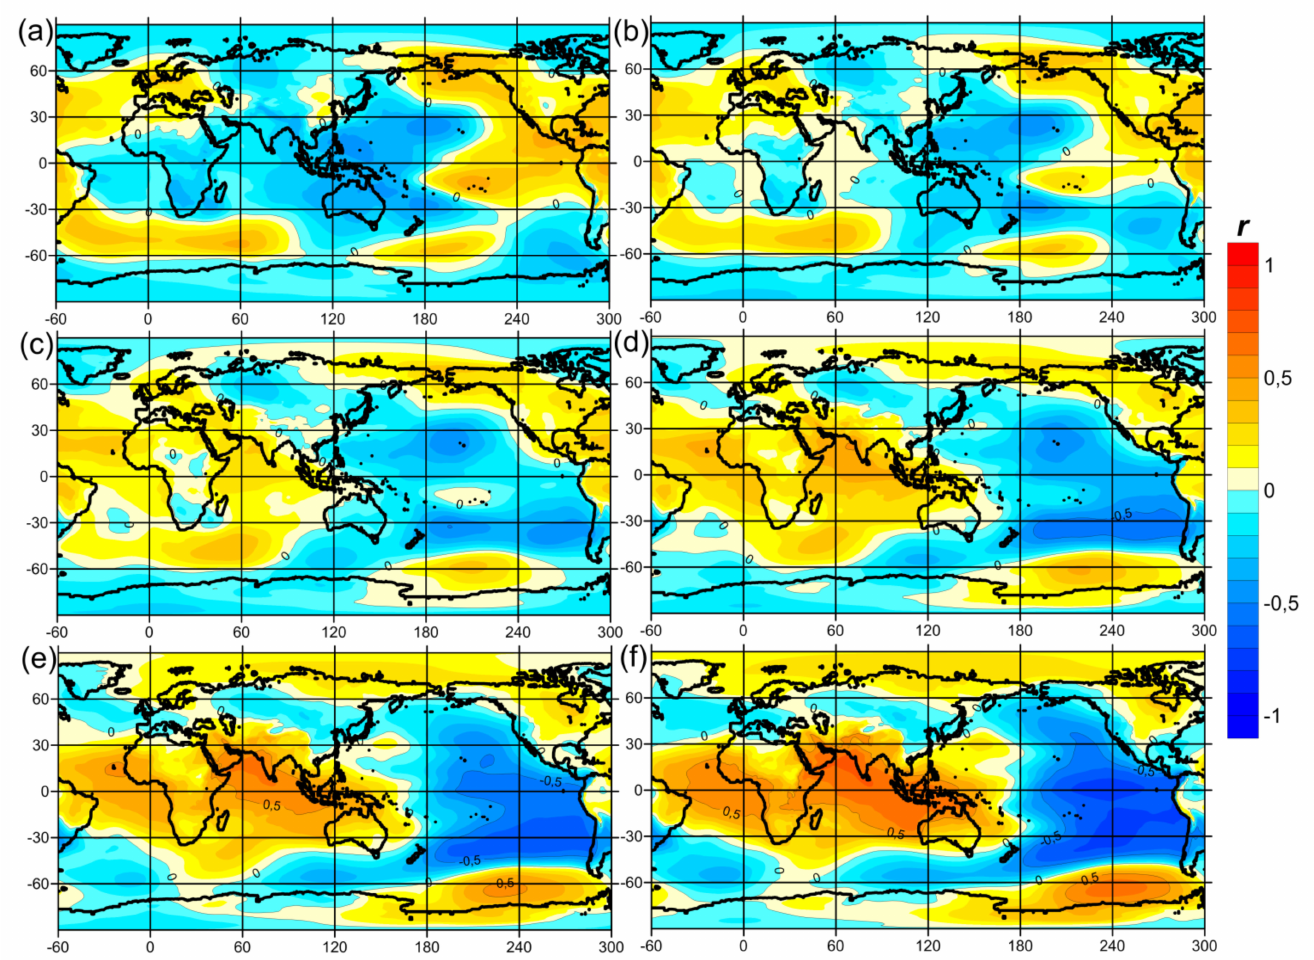
Figure 10. Cross-correlations between 14-month ( a ), 12-month ( b ), 10-month ( c ), 8-month ( d ), 6-month ( e ) and 4-month ( f ) shifts in sea-level pressure anomalies and the Global Atmospheric Oscillation Index (GAO2) with band-pass filtering from 2 to 7